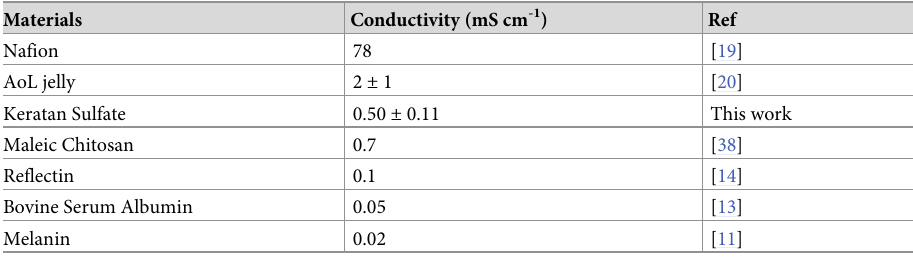
Table 1. Room-temperature proton conductivities of Nafion and known